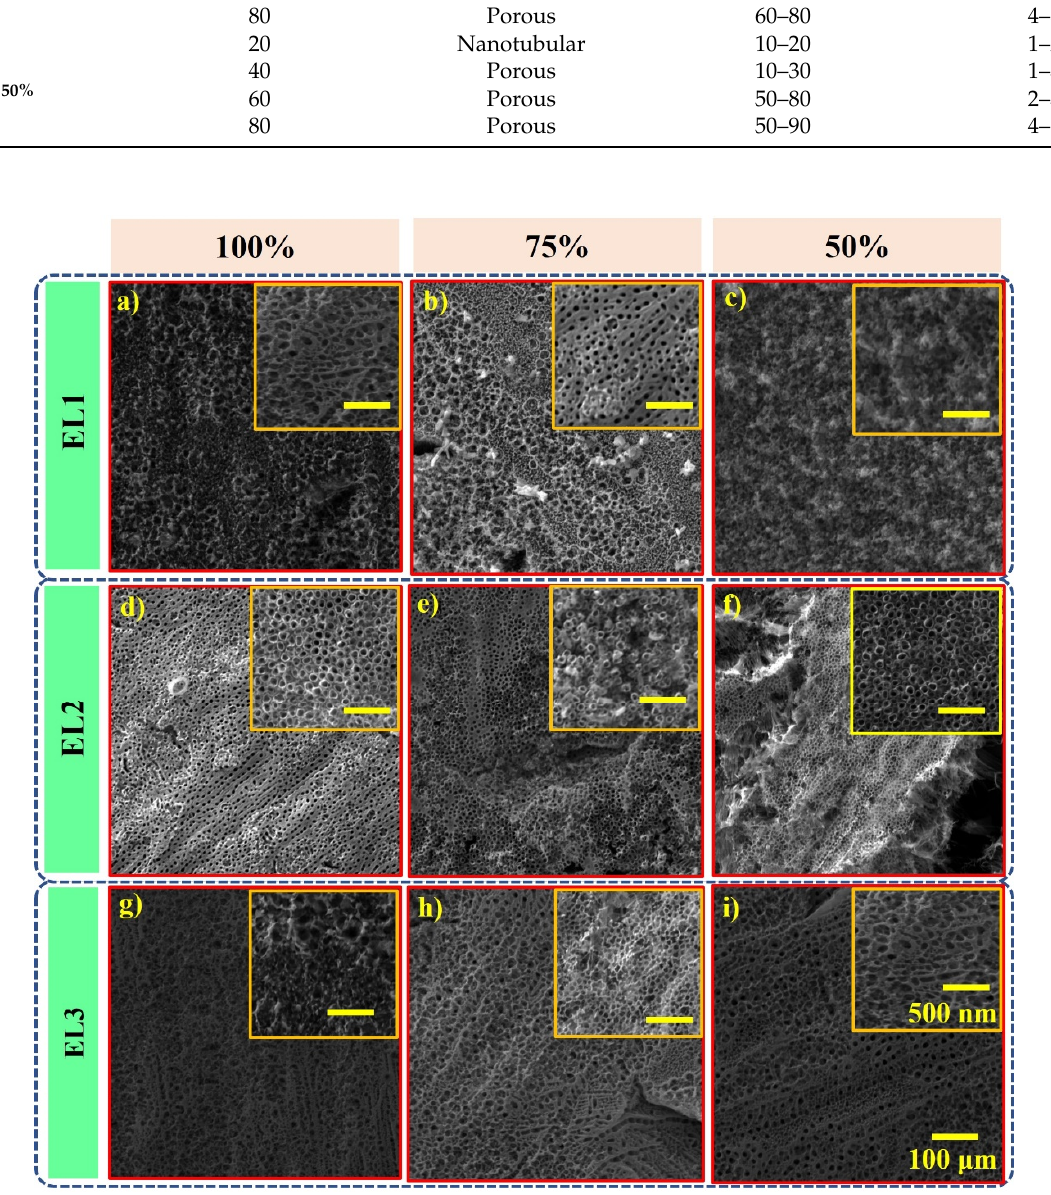
Figure 1. Representative SEM images of TNS prepared in different electrolytes (according to Table 1) at 60 V: ( a – c ) EL1 100% , EL1 75% , and EL1 50% , respectively, ( d – f ) EL2 100% , EL2 75% , and EL2 50% , respectively, and ( g – i ) EL3 100% , EL3 75% , and EL3 50% , respectively. Table 2. Morphological features of the prepared TNS in different electrolytes.